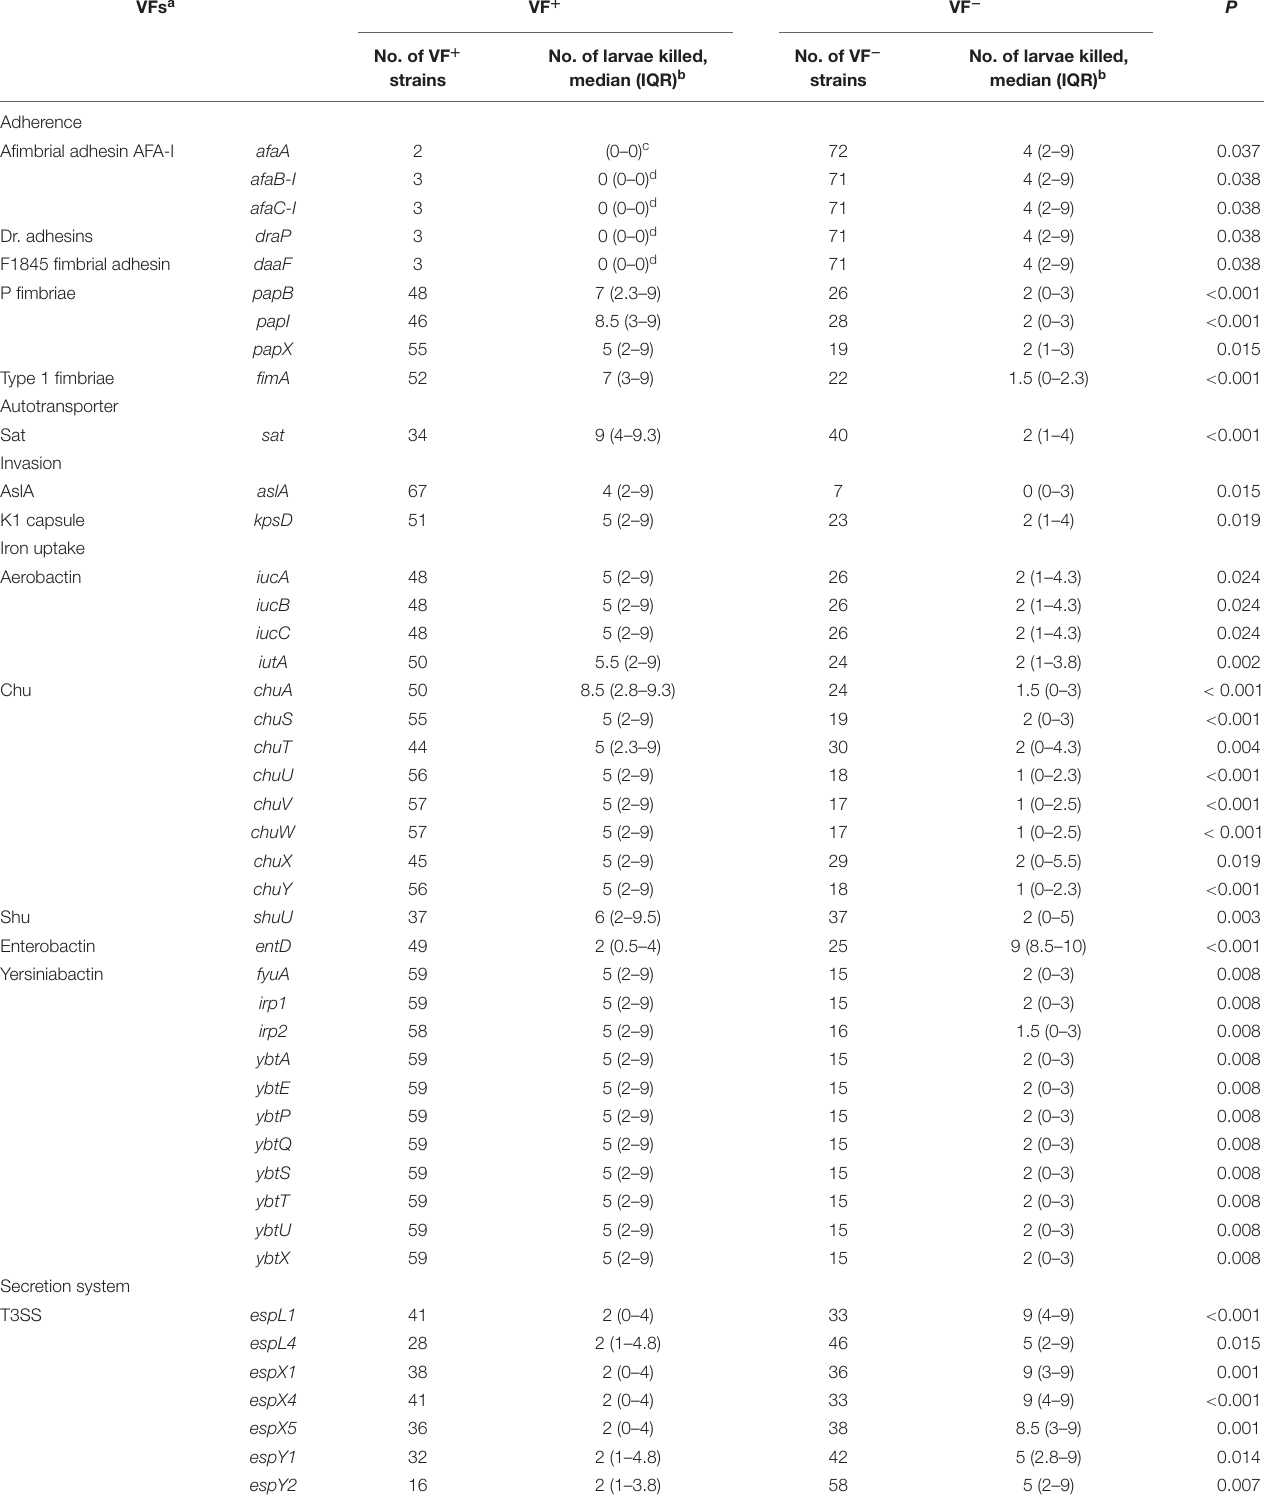
TABLE 2 | Associations between the number of larvae killed (experimental virulence) and the presence of a virulence factor (VF) among the 74 ExPEC strains. VFs a VF